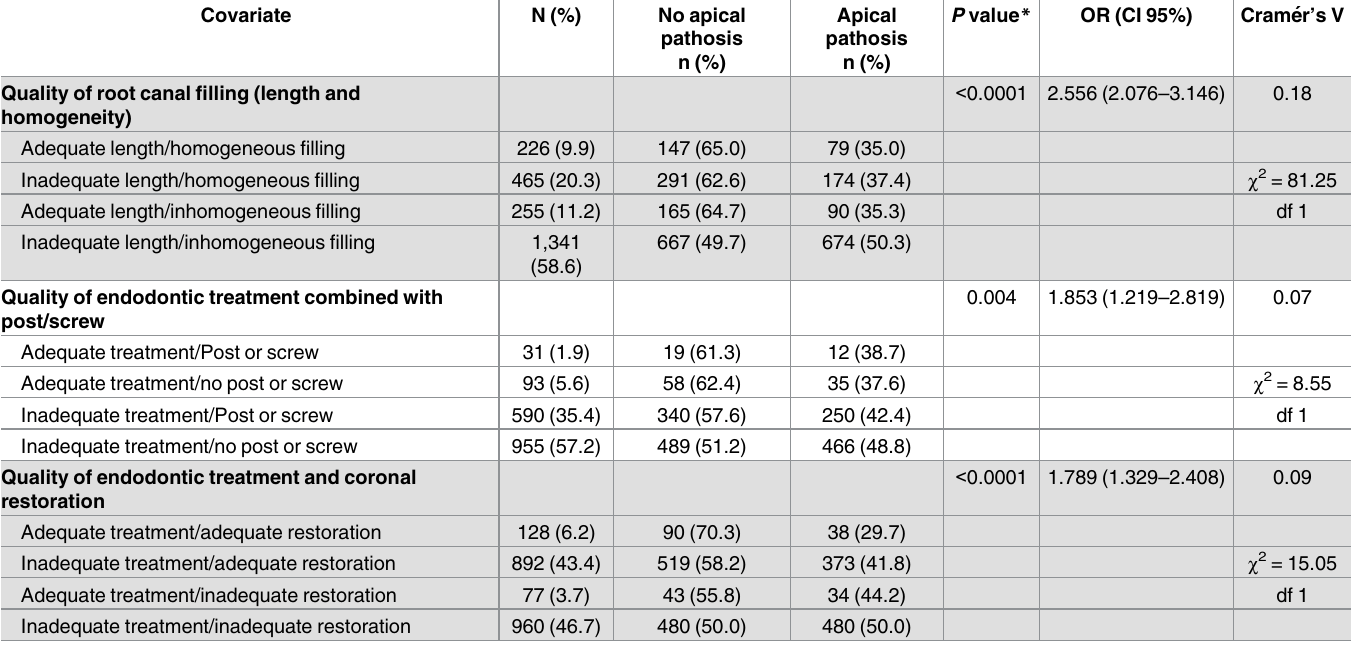
Table 5. Periradicular status in relation to various combined factors (). Covariate N